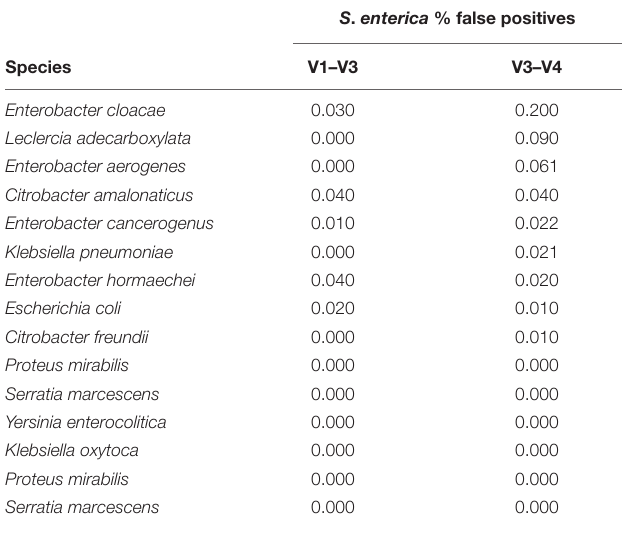
TABLE 1 | Salmonella enterica false positive rates for V1–V3 and V3–V4 16S rRNA amplicon